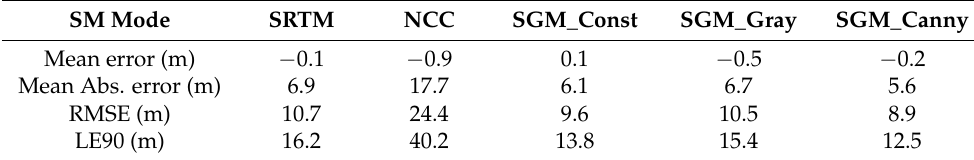
Table 7. Height accuracy of DSM generated from Stripmap stereo pair in test area